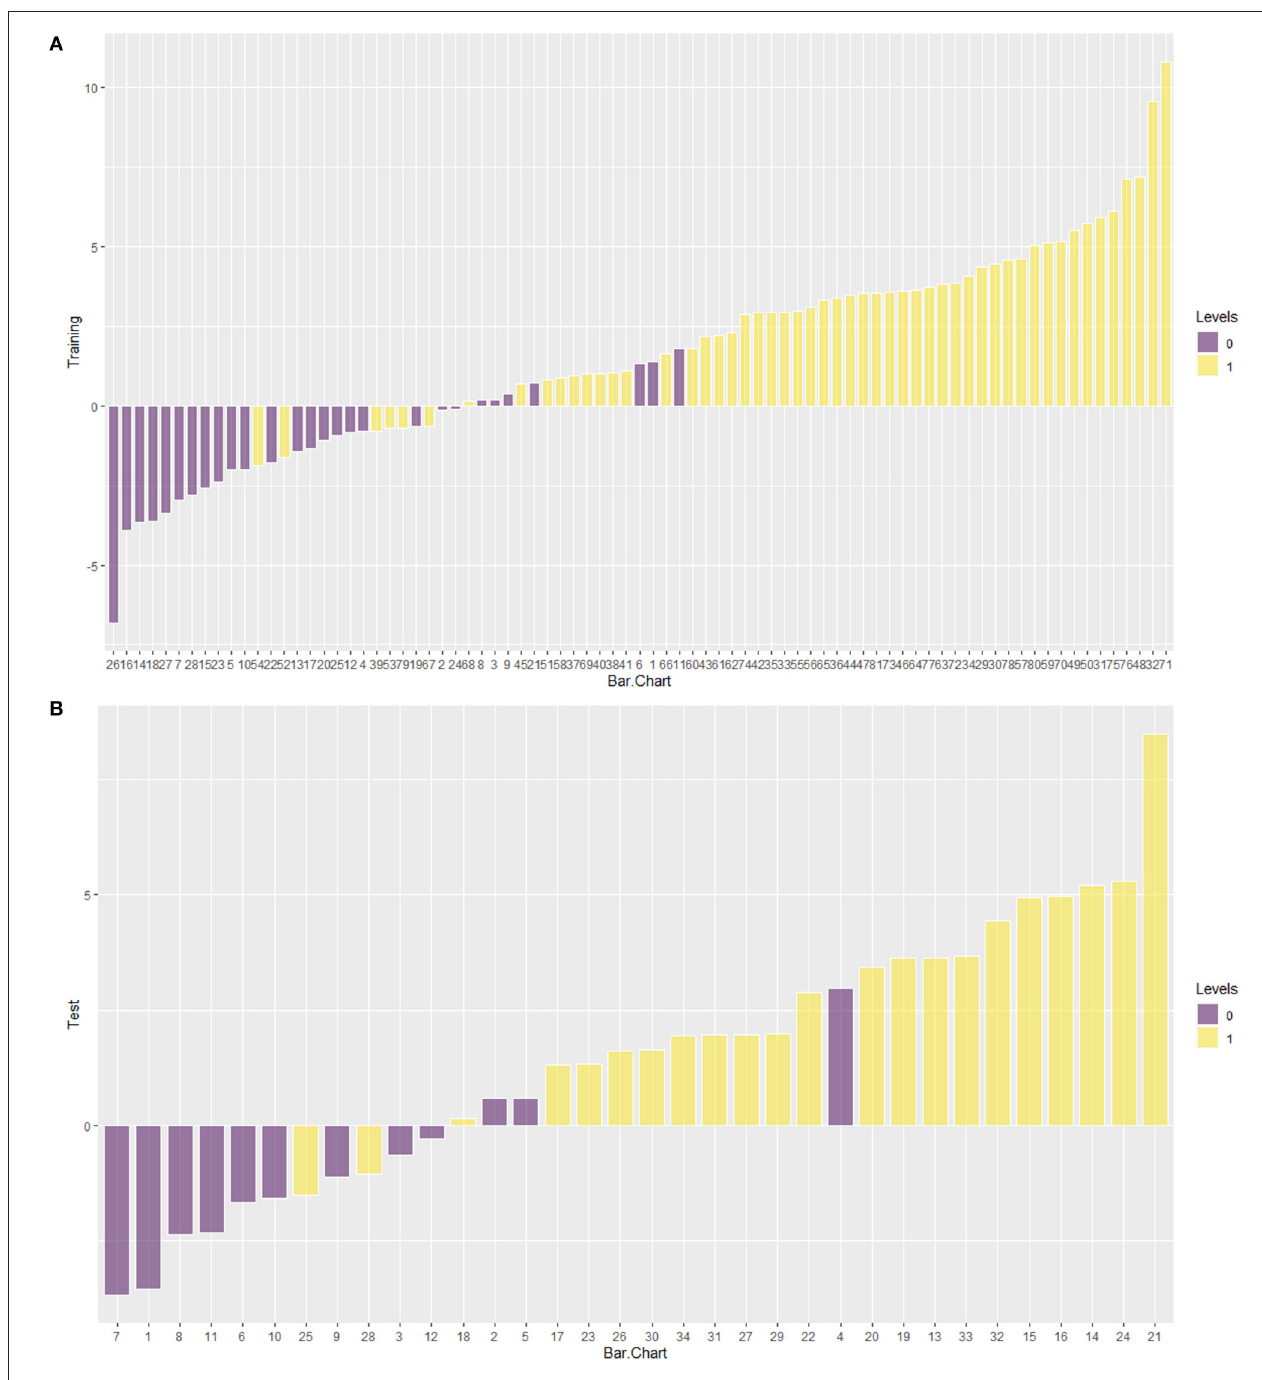
FIGURE 5 | Barchart of the Rad_clin model in the training group and the test group. Yellow means symptomatic plaque (SP) and purple means asymptomatic plaque (ASP). When purple appears in the yellow area, this means the SP patients had been incorrectly predicted as ASP. When yellow appears in the purple area, this means the SP patients had been incorrectly predicted as ASP. (A) was the training group, (B) was the test